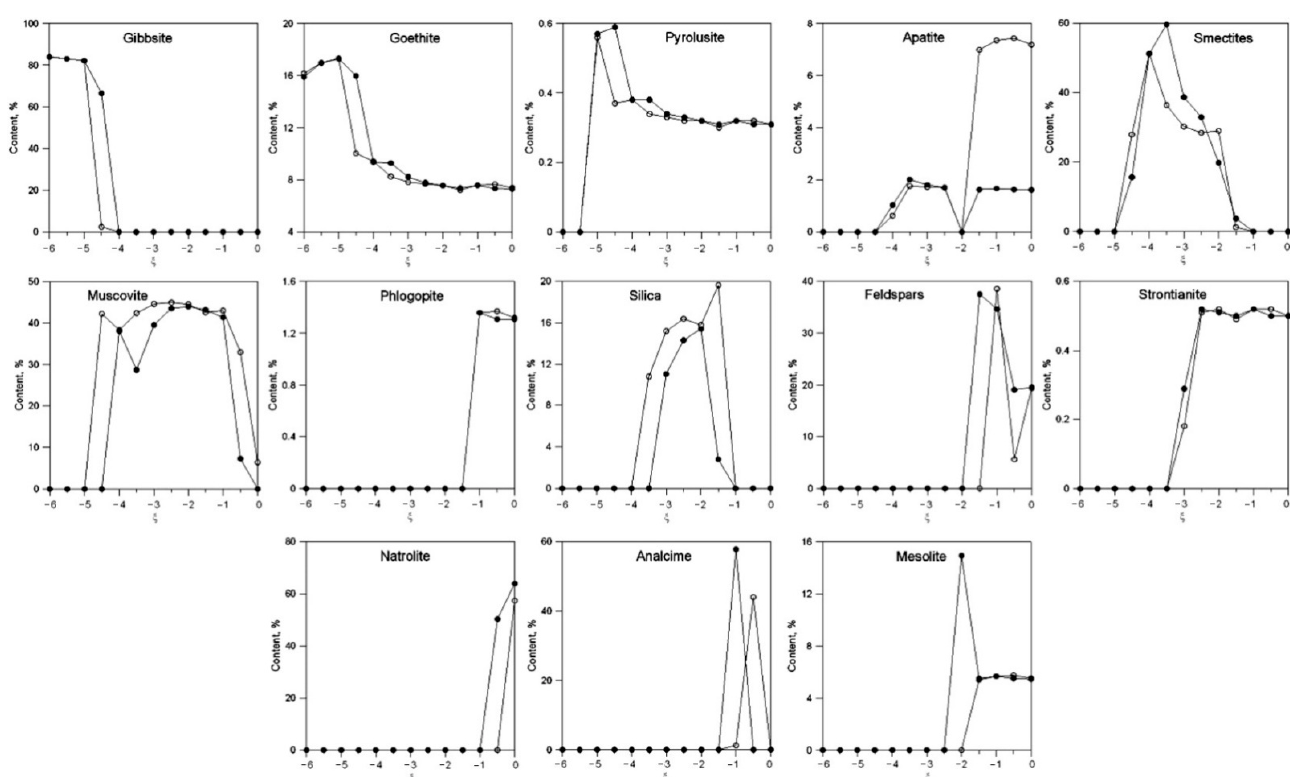
Figure 4. Change in the contents of newly formed minerals depending on ξ at 3 °C (white) and 20 °C (black).